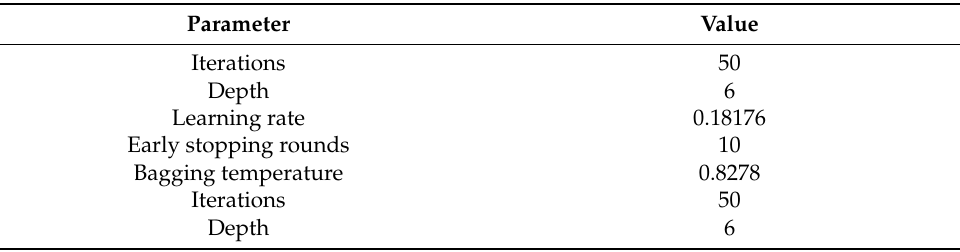
Table 6. Parameter settings for CatBoost (results of parameter optimization based on the Optuna method).